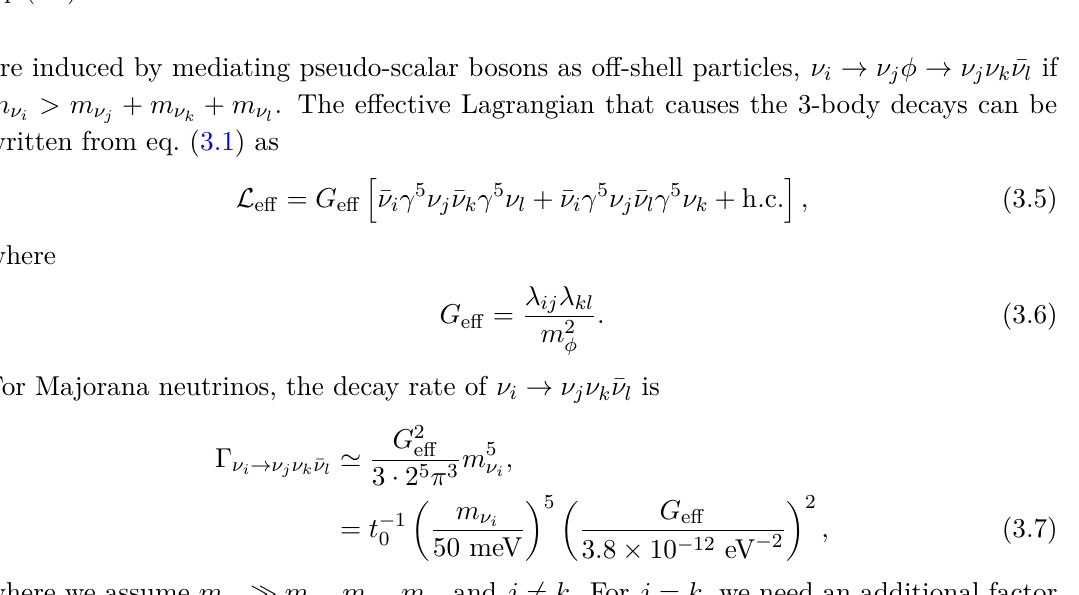
Figure 2 . Suppression factor, e − t 0 /τ νi , as a function of λ ij for several values of m ν eq.